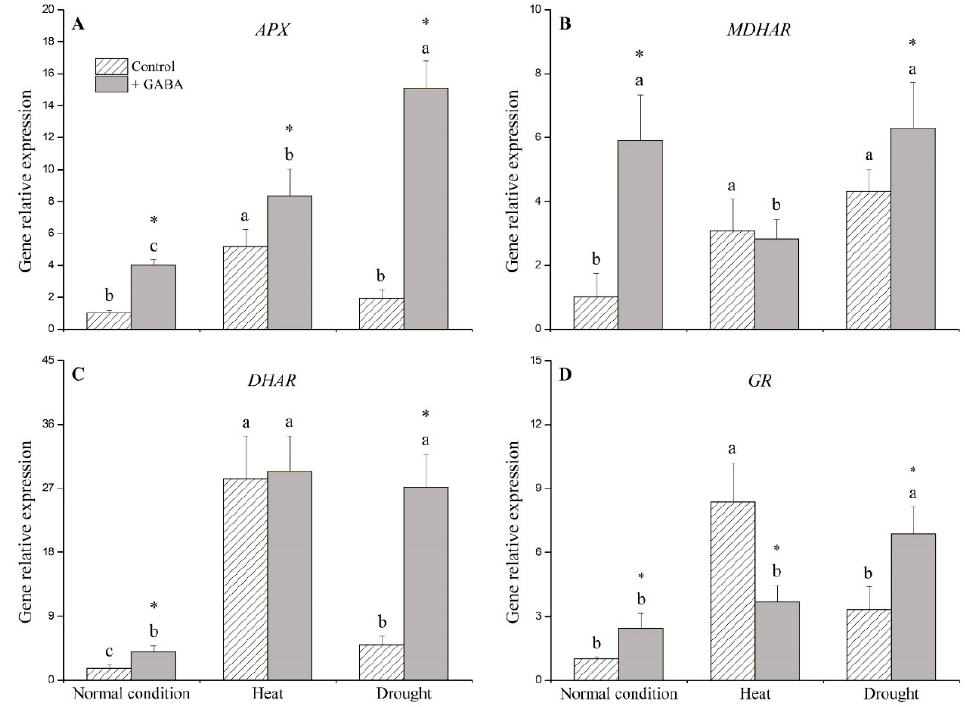
Figure 7. Effects of γ -aminobutyric acid (GABA) on genes’ expression of ( A ) ascorbate peroxidase ( APX ), ( B ) monodehydroascorbate reductase ( MDHAR ), ( C ) dehydroascorbate reductase ( DHAR ), and ( D ) glutathione reductase ( GR ) under normal, heat, and drought conditions. Vertical bars indicate ± SE of mean ( n = 4). Different letters above columns indicate significant differences for one particular treatment (control or +GABA) under different conditions; asterisk “*” indicates significant difference between control and +GABA treatment under a given condition.